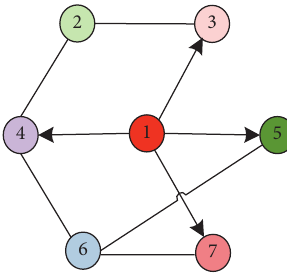
Figure 8: Communication topology G for the leader-following case.